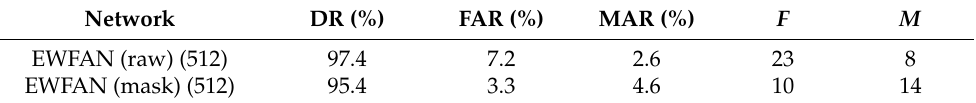
Table 2. Comparison of airport detection algorithms effectiveness of EWFAN network.